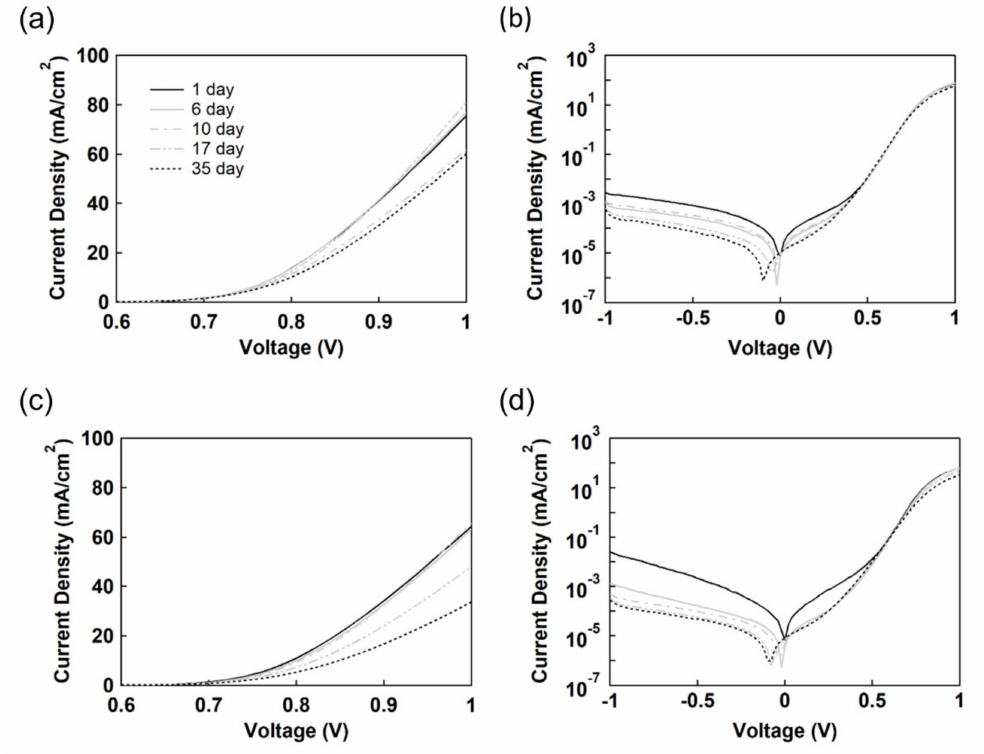
Figure 4. Linear and logarithmic current density–voltage (J–V) characteristics without the illumination of ( a , b ) CYTOP- encapsulated and ( c , d ) bare devices without illumination. Solid and dashed lines are the respective J–V characteristics of day 1 and day 35, where the grey lines are the curve of days between